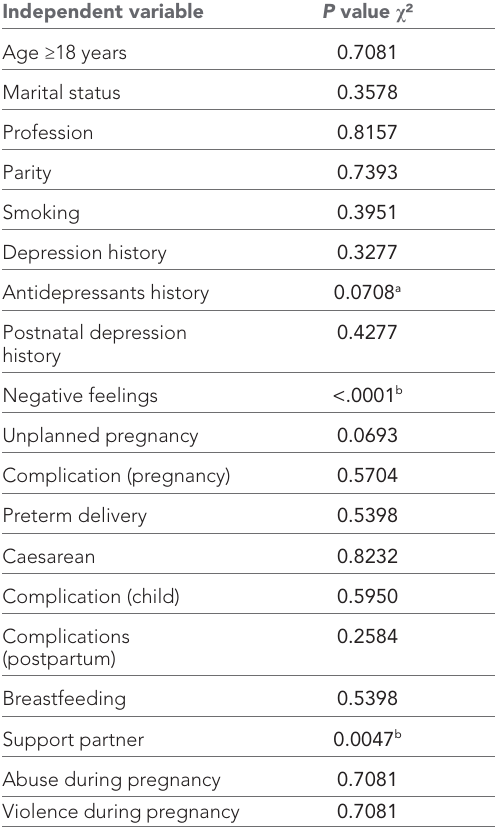
Table 2 Multivariate analysis with the dichoto- mised EPDS score as dependent variable